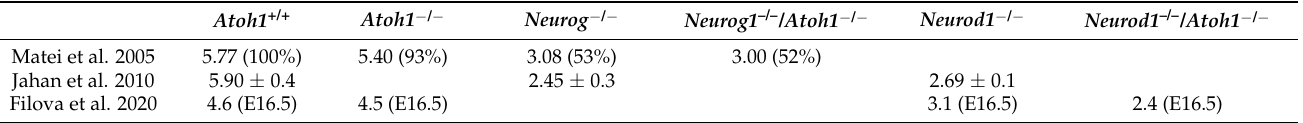
Table 1. The reduction in length of the cochlea depends on the loss of